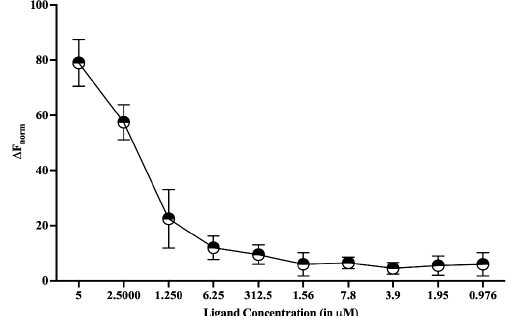
Figure 6. MicroScale Thermophoresis (MST). Dose-response curve to study the binding affinity between HEV-MTase and HPPA was plotted. The graph’s X-axis represents the concentration of ligand (HPPA), and the Y-axis represents the % fluorescence change. The calculated K d for HEV- MTase and HPPA was approximately 2 µ M. The graph describes the mean value of three independent experiments, and the error bar indicates the standard